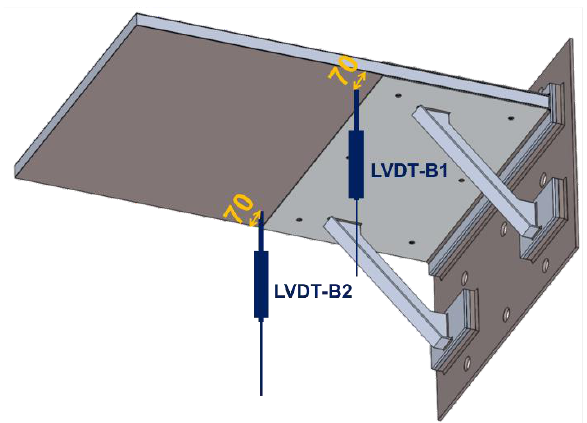
Figure 4. Position of LVDT-B1 and LVDT-B2 used in the second fatigue test. The experimental setup is displayed in Figure 5.